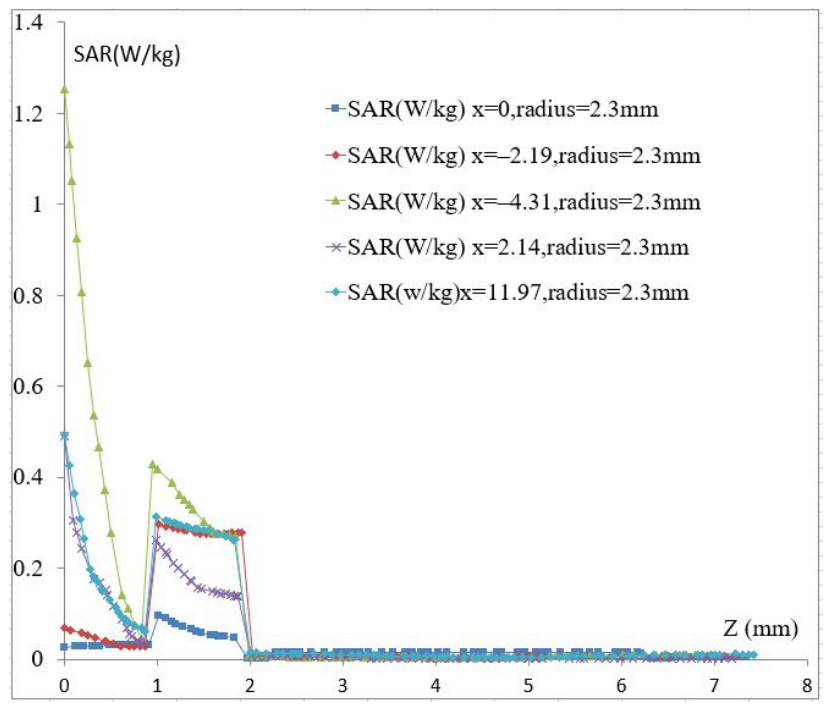
Figure 6. The calculated SAR. vs.